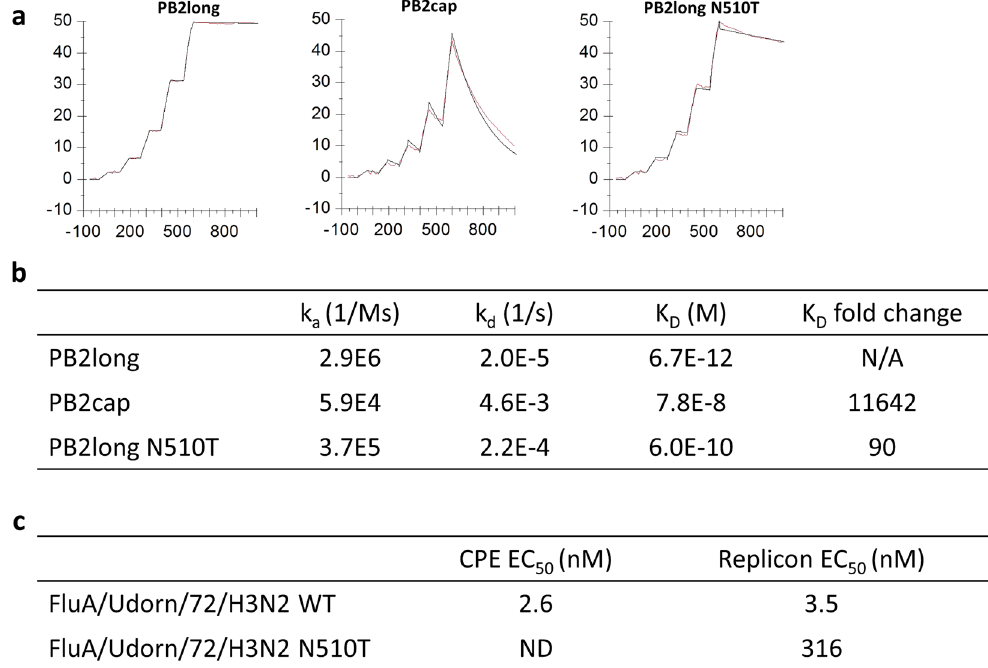
Figure 4. Comparison of FluA PB2long, PB2cap and PB2long N510T mutant by SPR binding assay and cell activity assays. ( a ) Single-cycle SPR sensorgrams for interactions of VX-787 with PB2long (left), PB2cap (middle) and PB2long N510T mutant (right). ( b ) Association (K a ) and dissociation rates (K d ), dissociation constant (K D ), and fold change in K D of VX-787 with three PB2 forms in the SPR assay. ( c ) Cellular activity of VX-787 in the CPE assay and EC 50 shift in the replicon assay between wild type and the N510T PB2 proteins. Range of concentration tested: 100 μ M to 3.16 pM, 16-point dilutions. ND: not